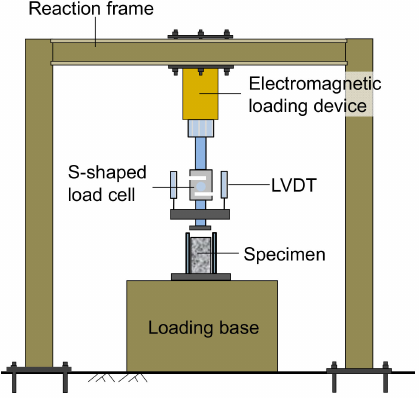
Figure 2. Schematic of plane strain cyclic compression